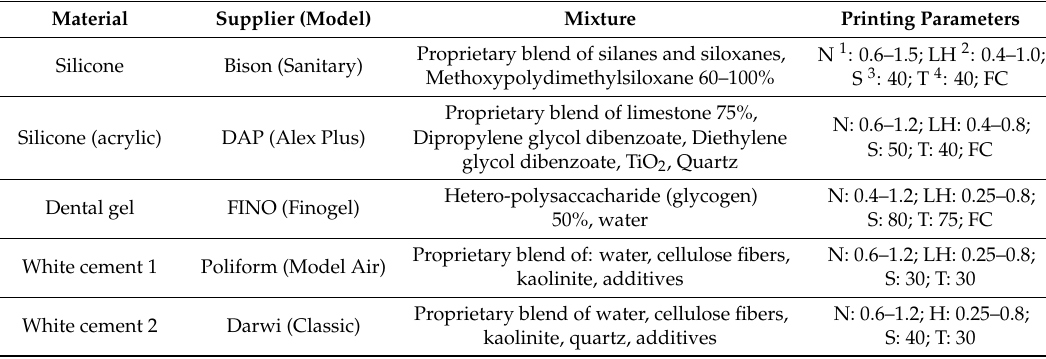
Table 3. Materials used during testing and process parameters.